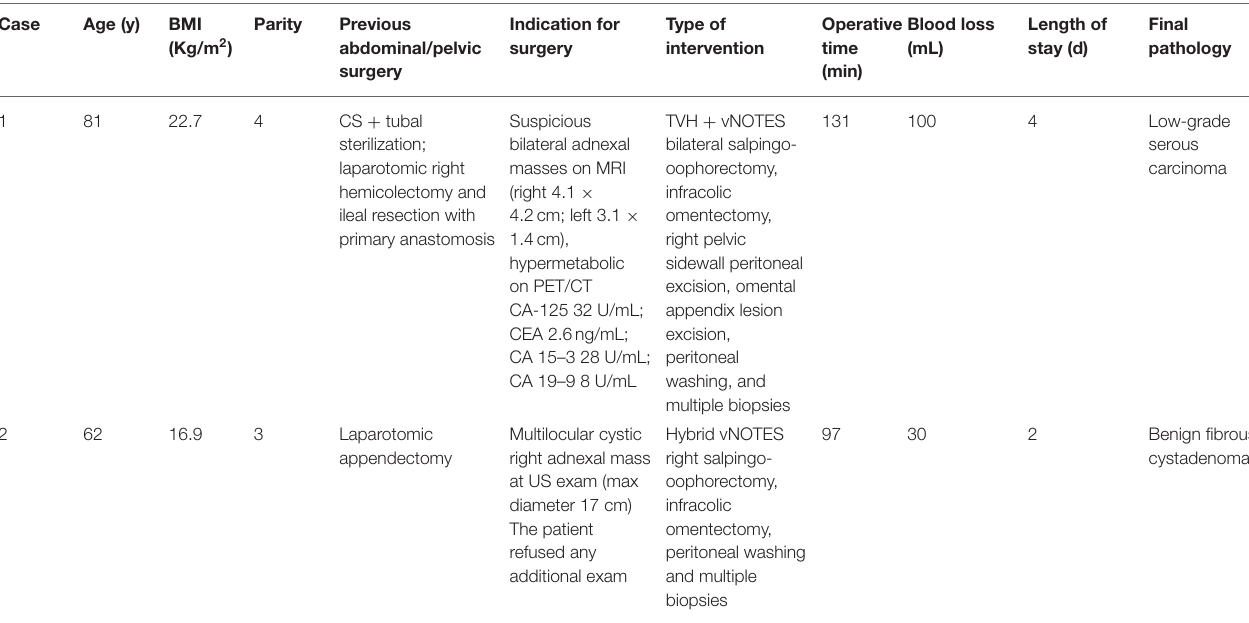
TABLE 1 | Demographic, clinical, intraoperative, and postoperative